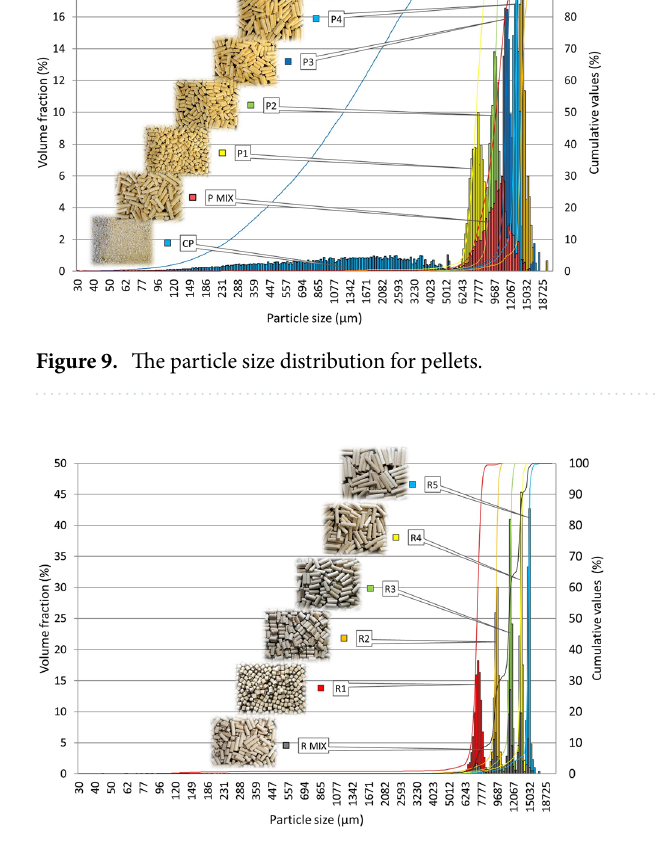
Figure 10. The particle size distribution for